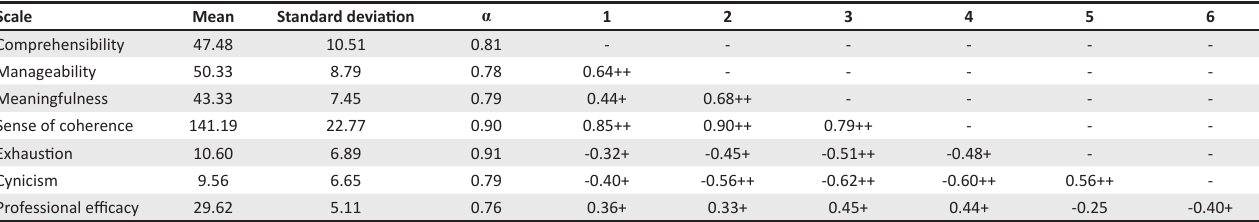
TABLE 2: Descriptive statistics, alpha coefficients and Pearson correlations of the measuring instruments. Scale